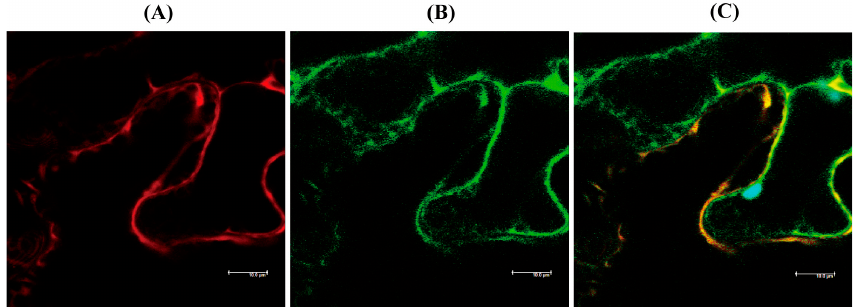
Figure 4. Localization of human Naa50. ( A ) Red fluorescence of hNaa50-mCherry. ( B ) Green fluo- rescence of cytoplasmic GFP. ( C ) Merged image ( A + B ). Leaves of 30-day-old tobacco ( Nicotiana ben-